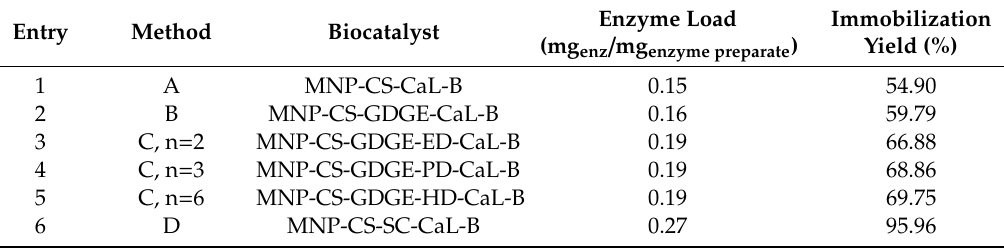
Table 4. The enzyme load in the prepared biocatalyst (Scheme 2).